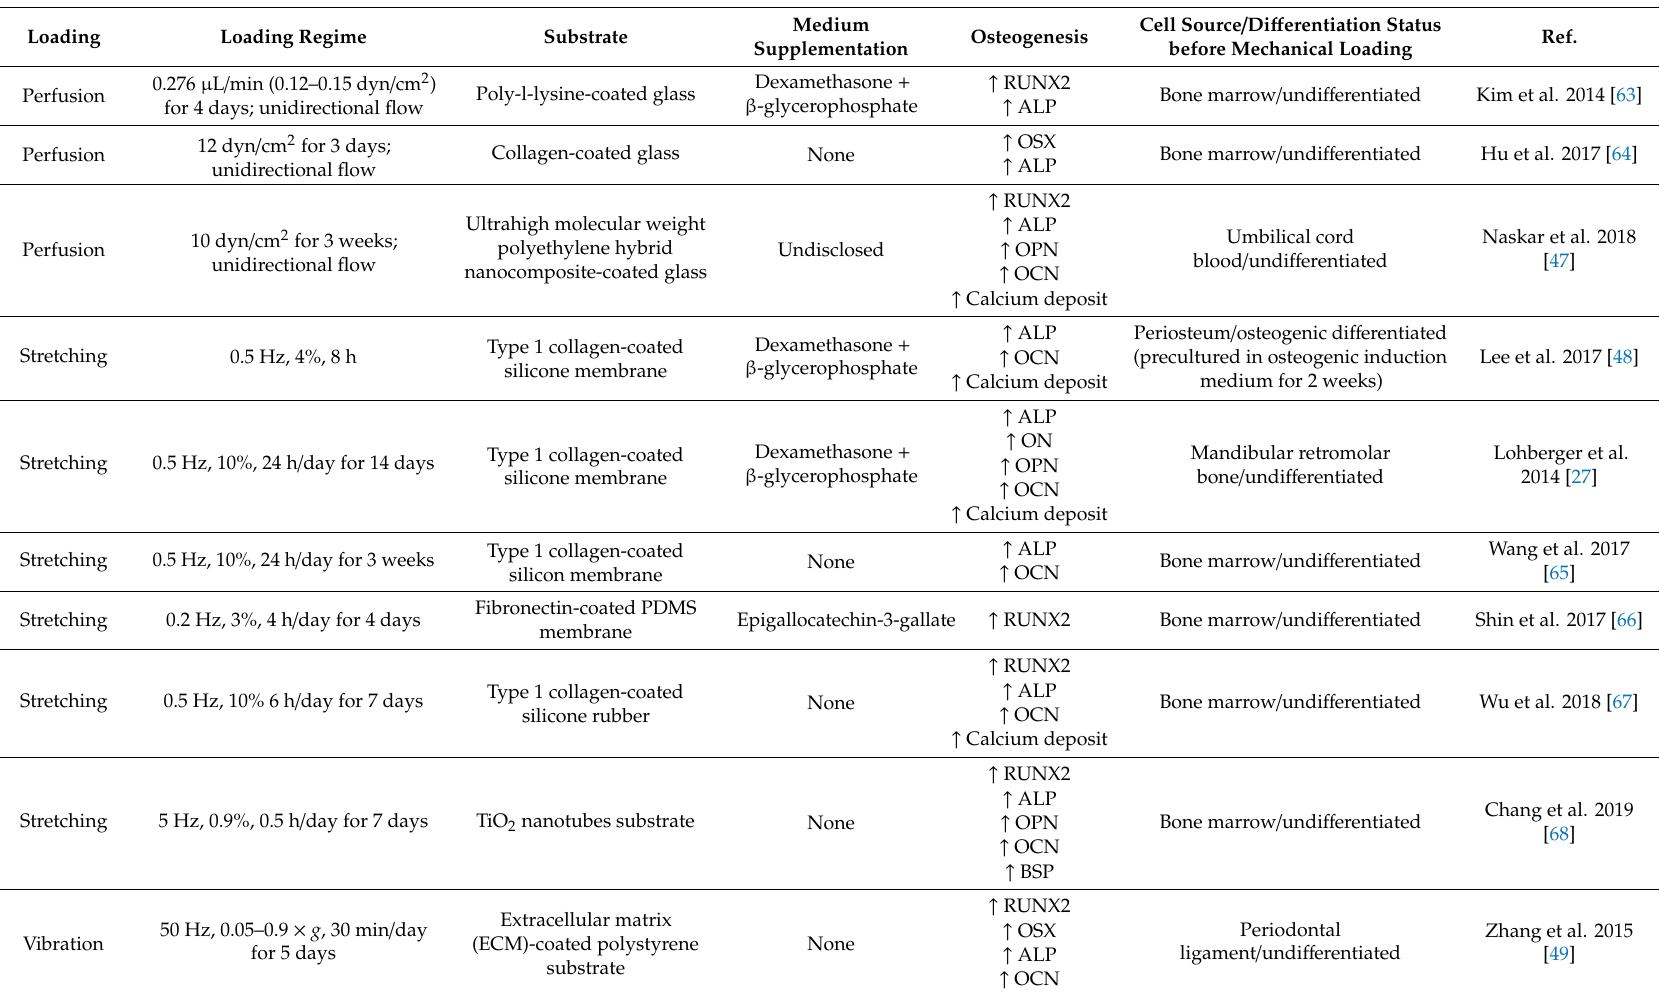
Table 1. Summary of the recent studies on e ff ects of mechanical loading towards the osteogenesis of human mesenchymal stem cells (hMSCs) in a 2D planar